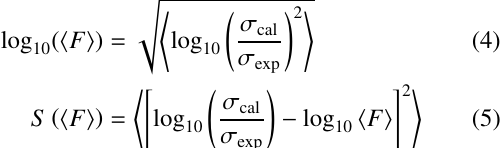
Table 3. The Calculation model